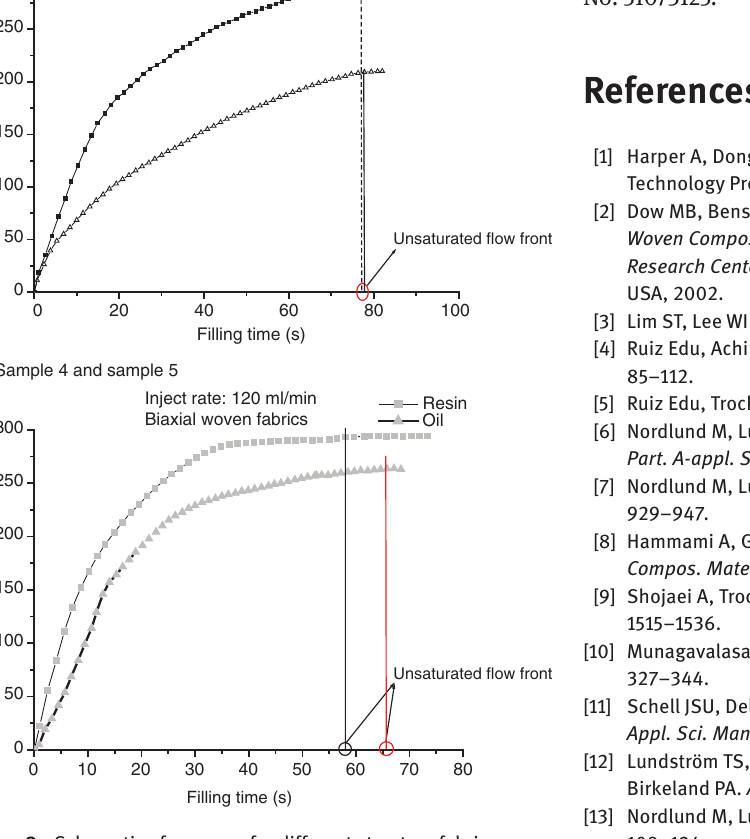
Figure 8: Schematic of pressure for different structure